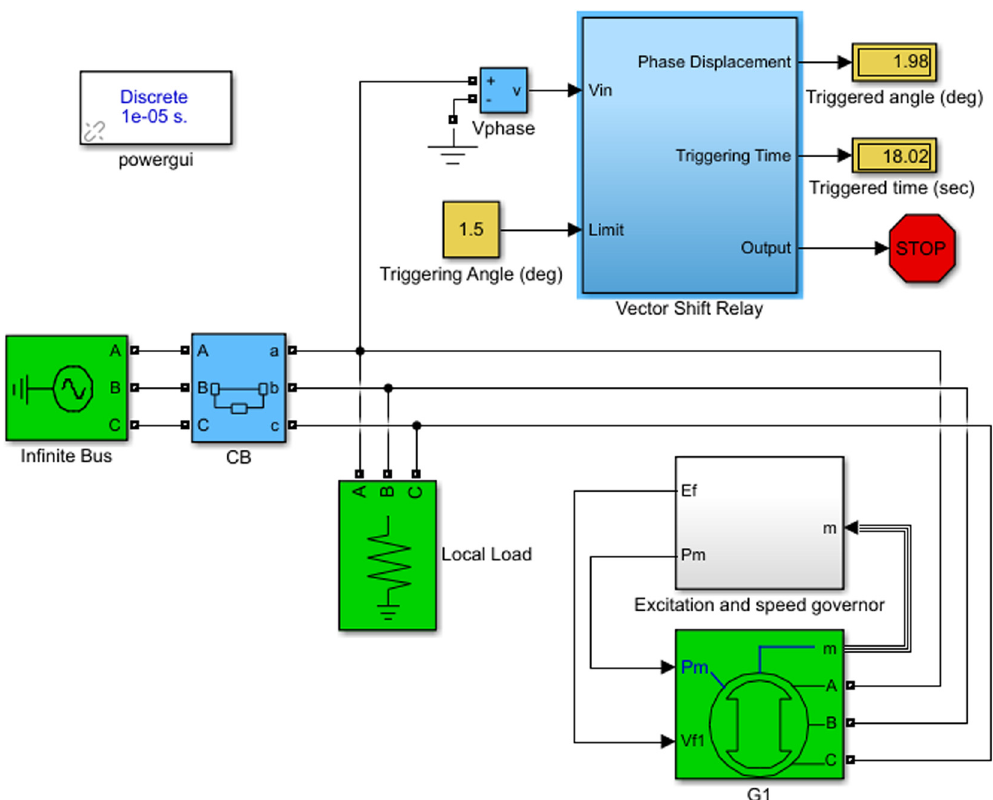
Figure 4: Diagram of DG connected parallel to the grid.